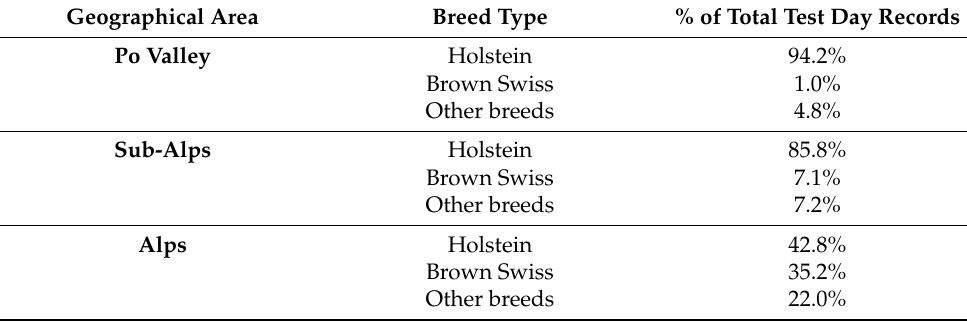
Table 1. Distribution of samples among geographical areas and